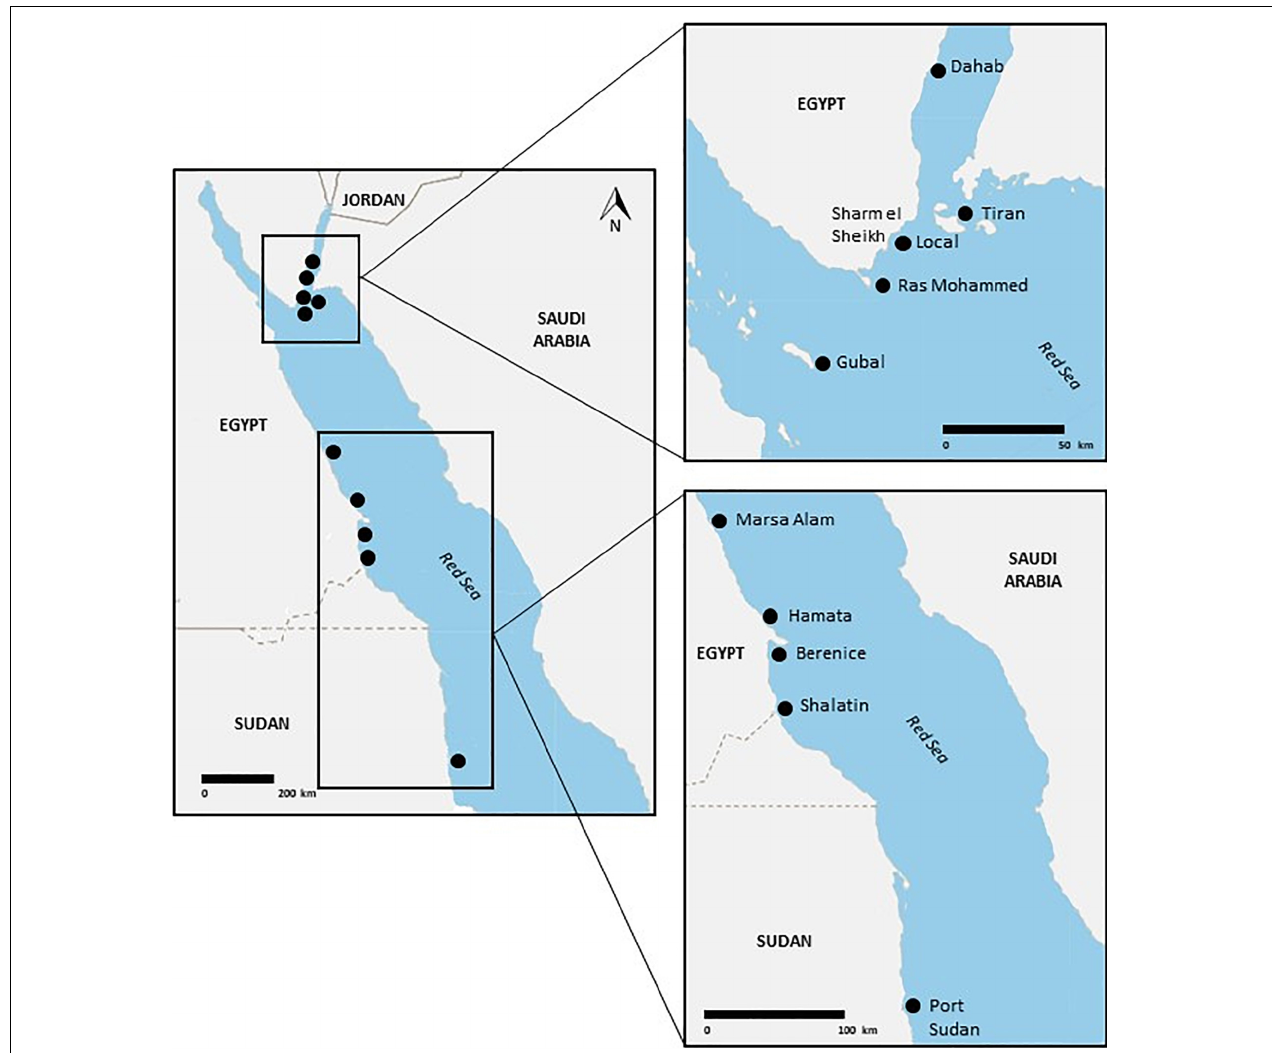
FIGURE 1 | Red Sea map with black dots indicating sites in which data for the reliability analysis were collected.